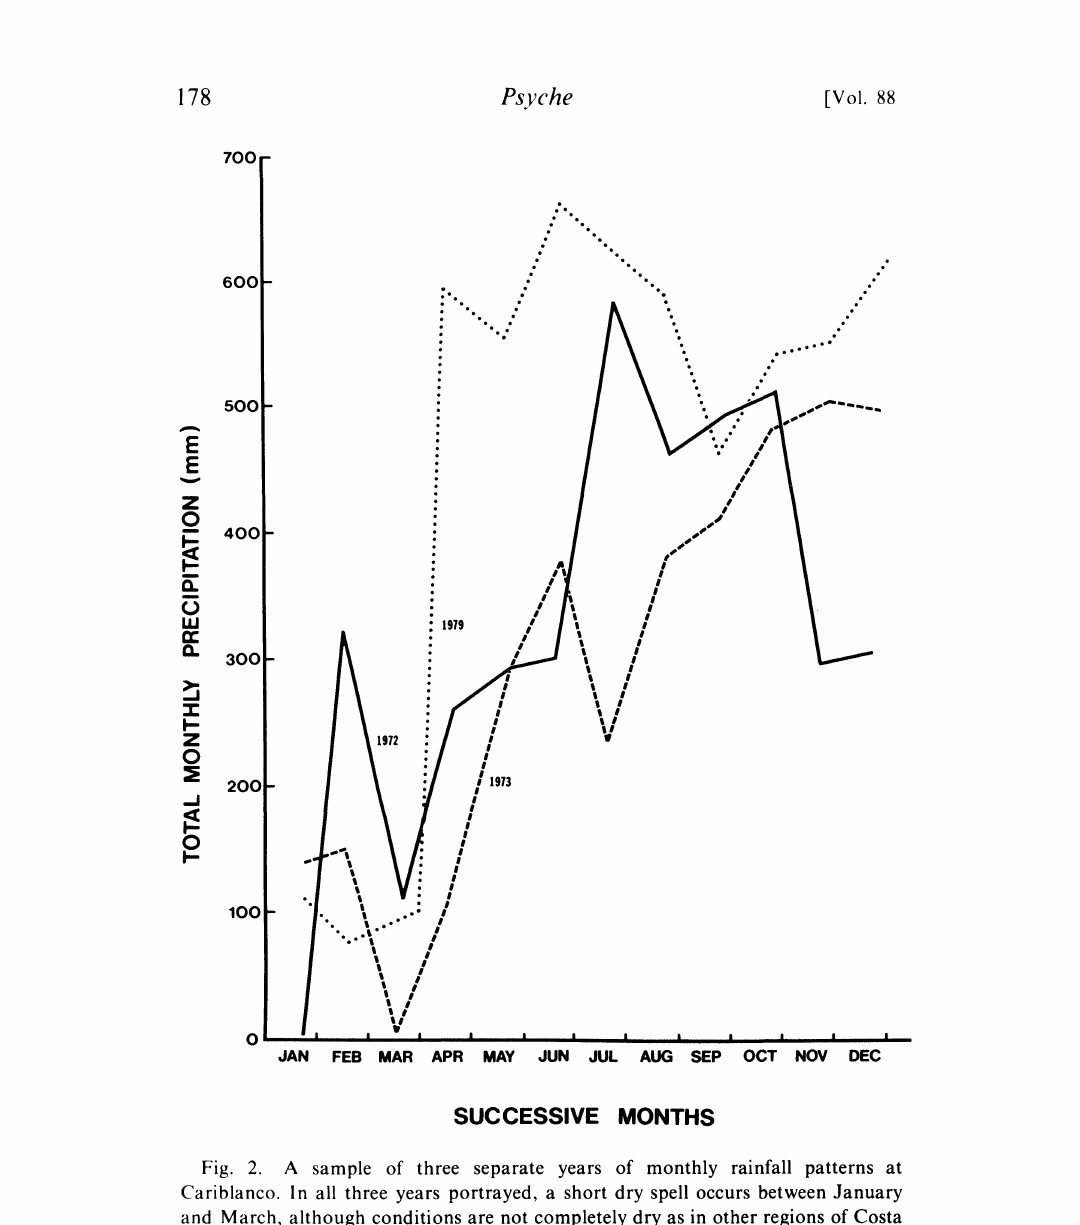
Fig. 2. A sample of three separate years of monthly rainfall patterns at Cariblanco. In all three years portrayed, a short dry spell occurs between January and March, although conditions are not completely dry as in other regions of Costa Rica with distinct dry